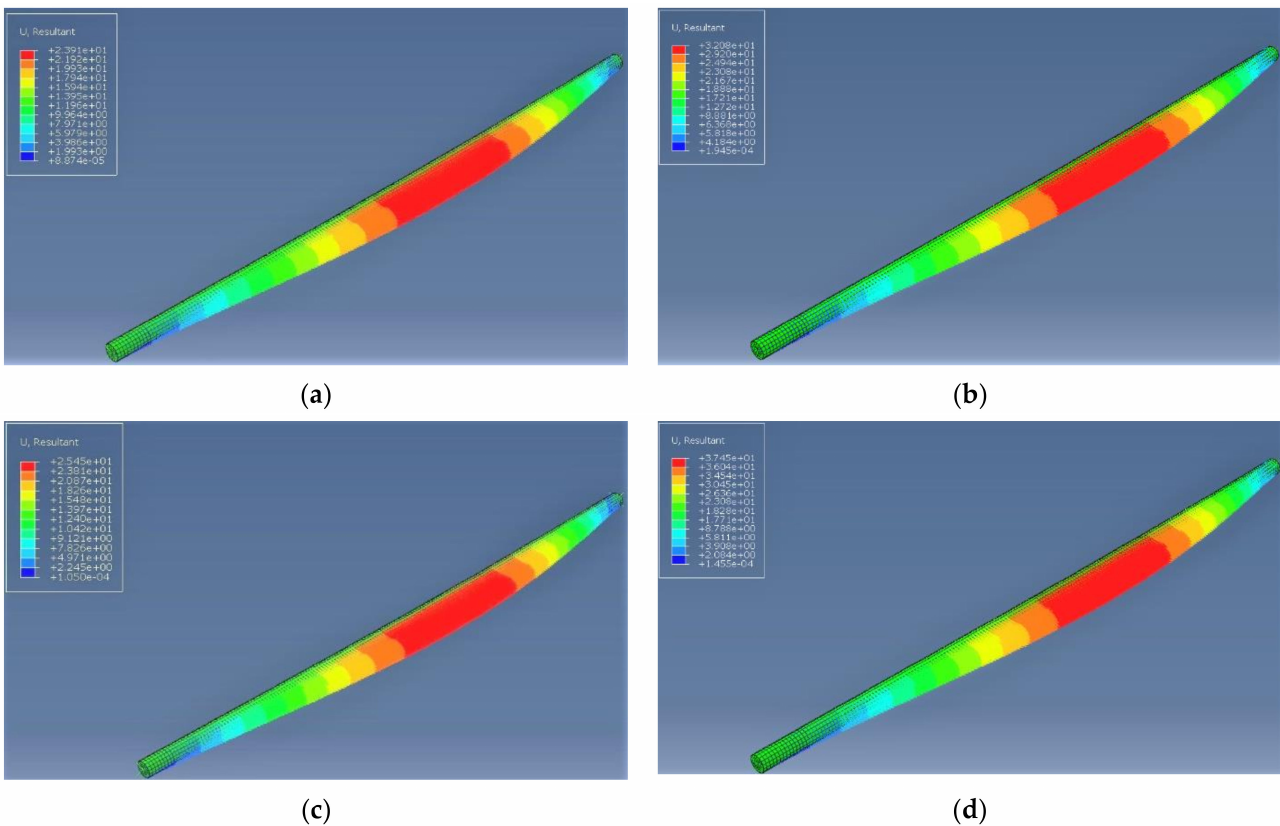
Figure 11. Horizontal displacements in the deformed models: ( a ) CS1; ( b ) CS2; ( c ) CS3; ( d )